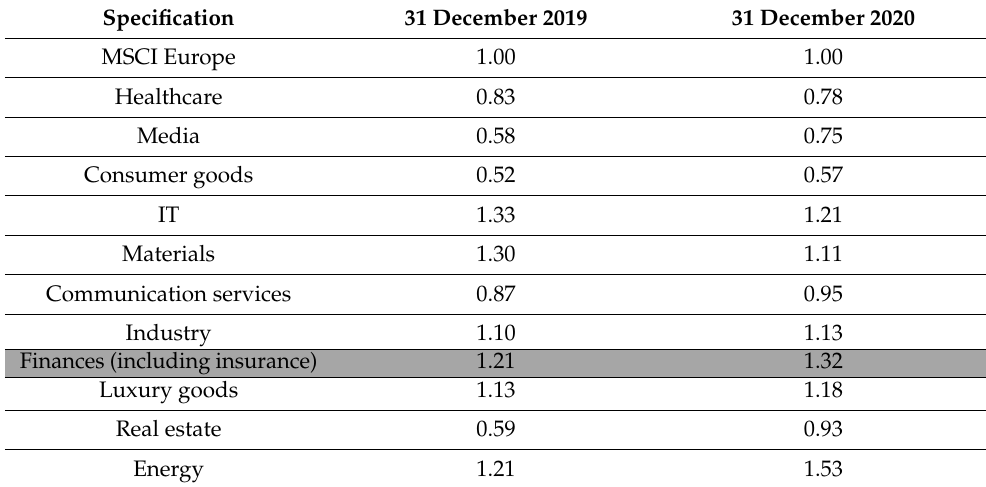
Table 2. Beta factors of MSCI Europe